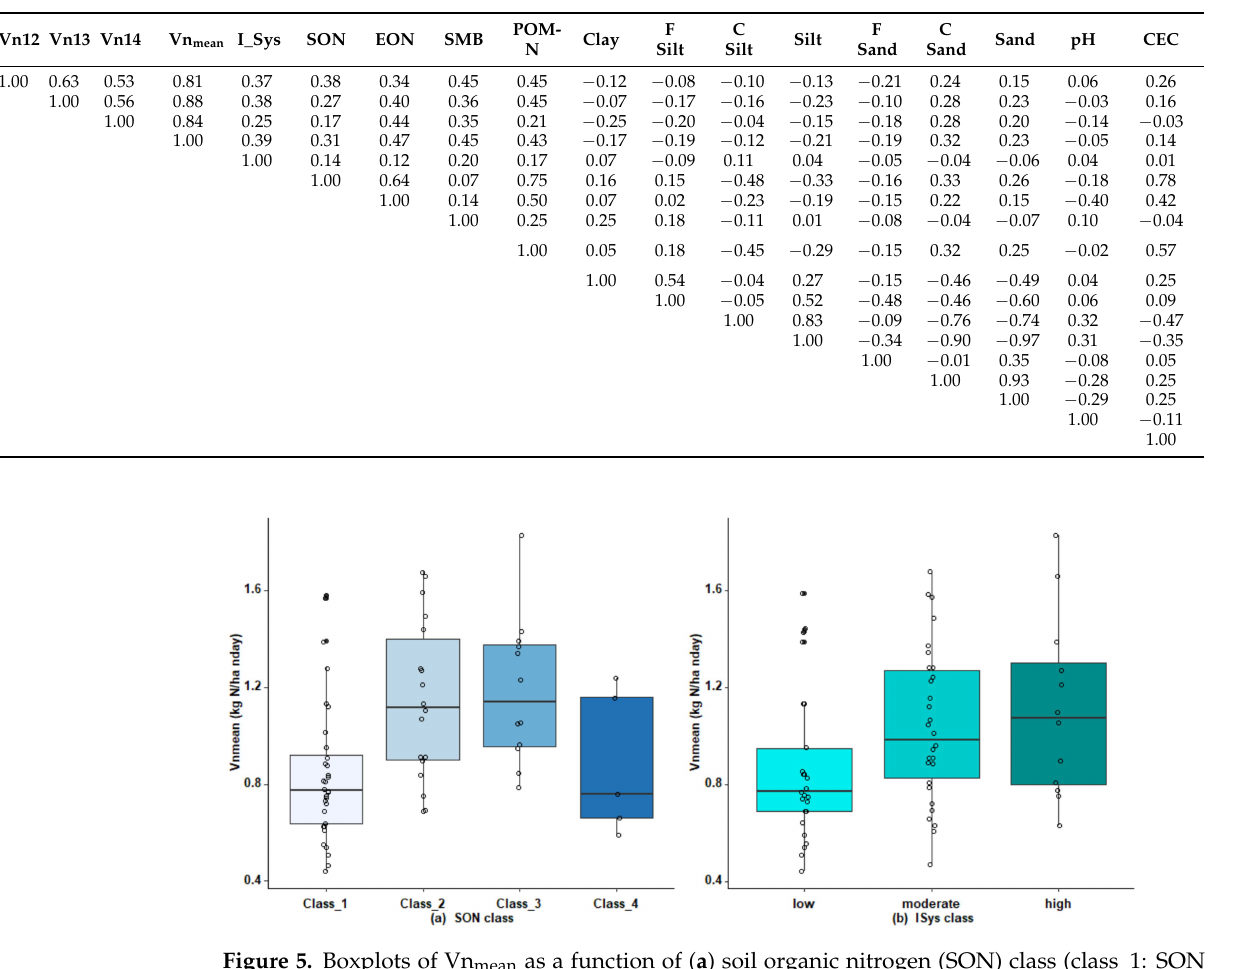
Figure 5. Boxplots of Vn mean as a function of ( a ) soil organic nitrogen (SON) class (class_1: SON < 5.7 t N ha − 1 ; class_2: [5.7; 7.15]; class_3: [7.15; 8.2]; class_4: >8.2 t N ha − 1 ) and ( b ) I_Sys class. Whiskers extend to 1.5 times the interquartile